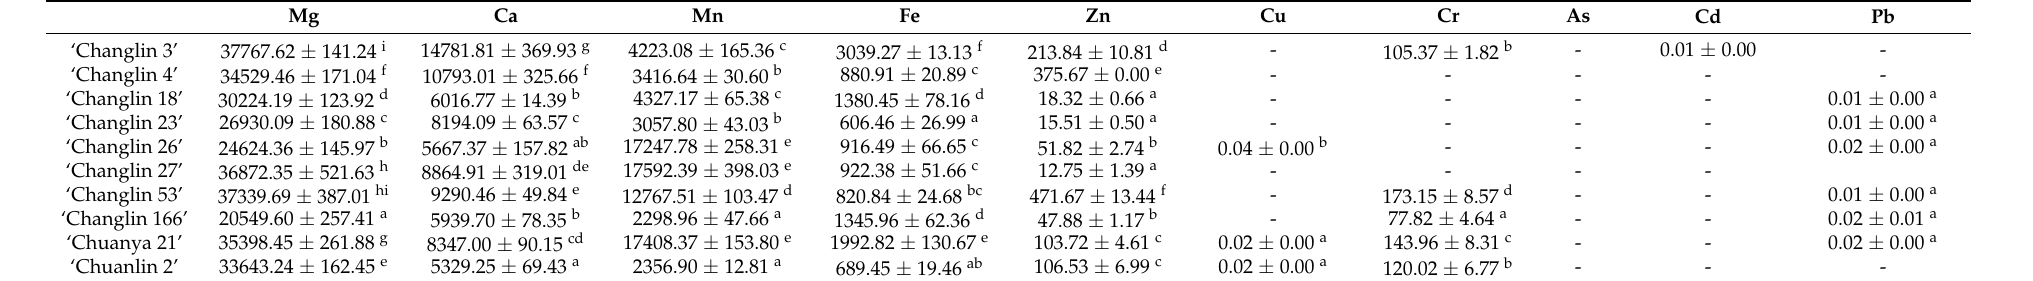
Table 4. Concentration of trace elements in the C. oleifera oil of ten cultivars ( µ g/kg